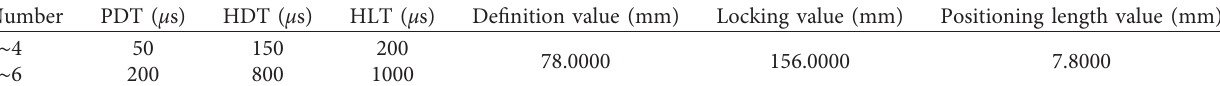
Table 2: AE channel and positioning settings.